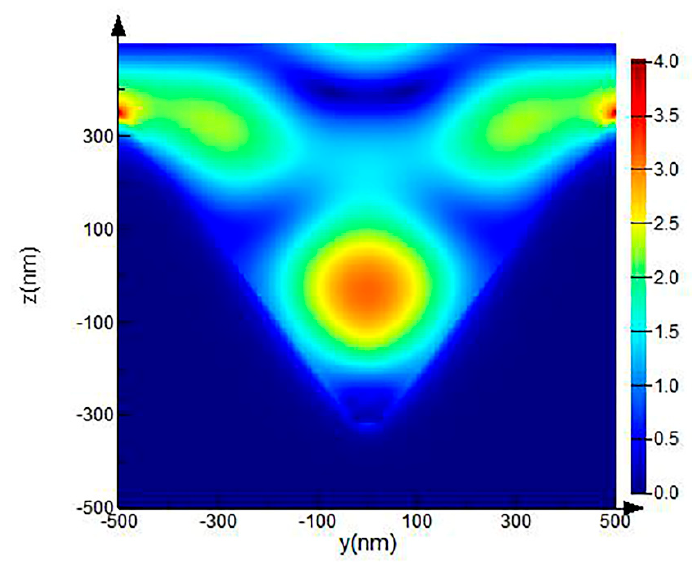
Figure 6. Electric field distribution diagram of Ag/IPS with pits in the y-z plane.